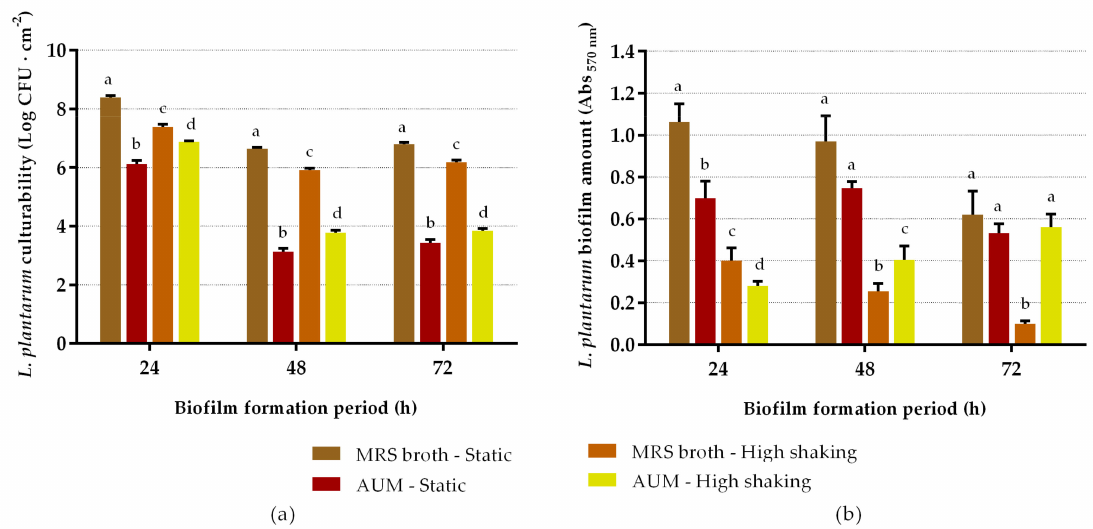
Figure 1. Culturability ( a ) and total biomass ( b ) of L. plantarum biofilms after 24, 48 and 72 h of development. Biofilms were formed on silicone in two different media (AUM and MRS broth) and at two hydrodynamic conditions (static and high shaking conditions). The data shown represent the mean and standard deviation (SD) of at least three independent experiments. Different lower-case letters indicate statistically significant differences between the same biofilm formation times ( p <